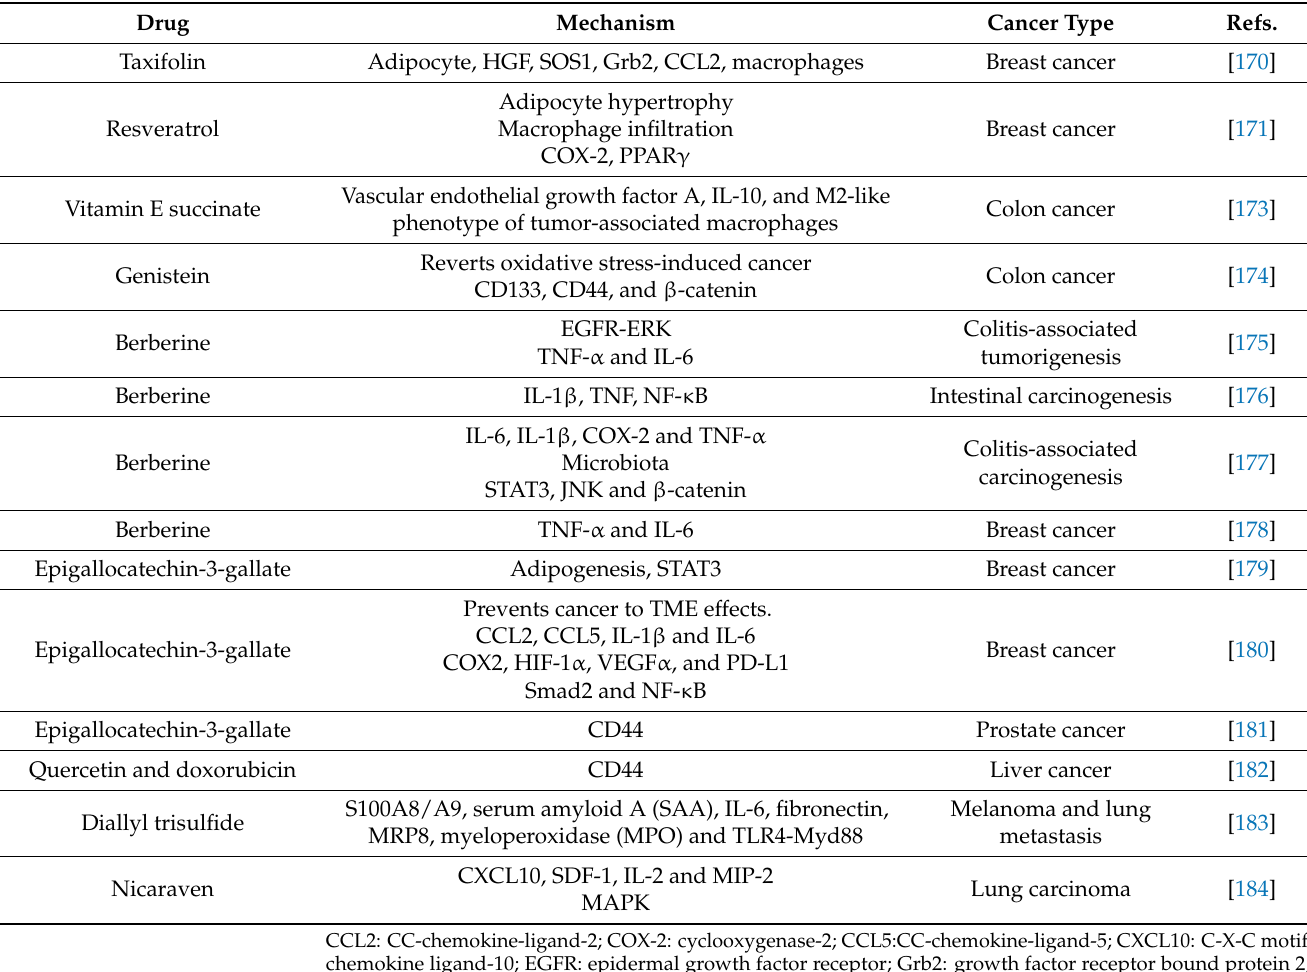
Table 5. Antioxidant effects in the tumor